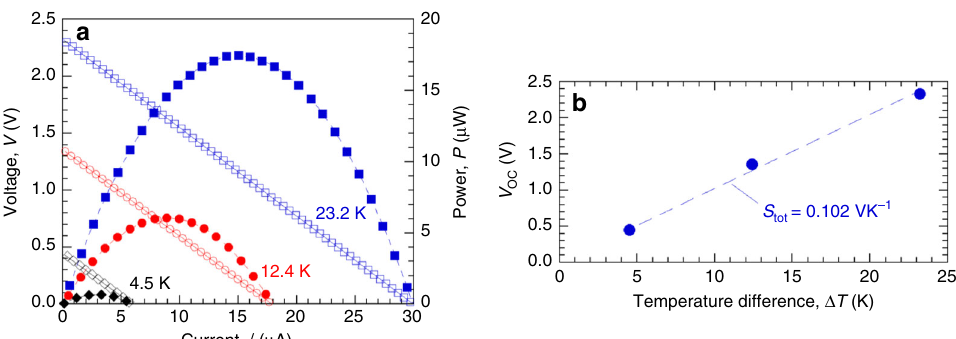
Fig. 3 Performance of a harvest mode µ TEG. a Power – current – voltage data with T C = 300 K and Δ T = 4.5 K (black diamonds), 12.4 K (red circles), 23.2 K (blue squares). Open symbols are voltage data (left axis) and fi lled symbols are generated power = V · I data (right axis). Dashed lines are linear (for I – V ) and quadratic (for I – P ) least-square fi ts to the data. b Open circuit voltage V OC vs. Δ T . The dashed line is a linear least-square fi t.